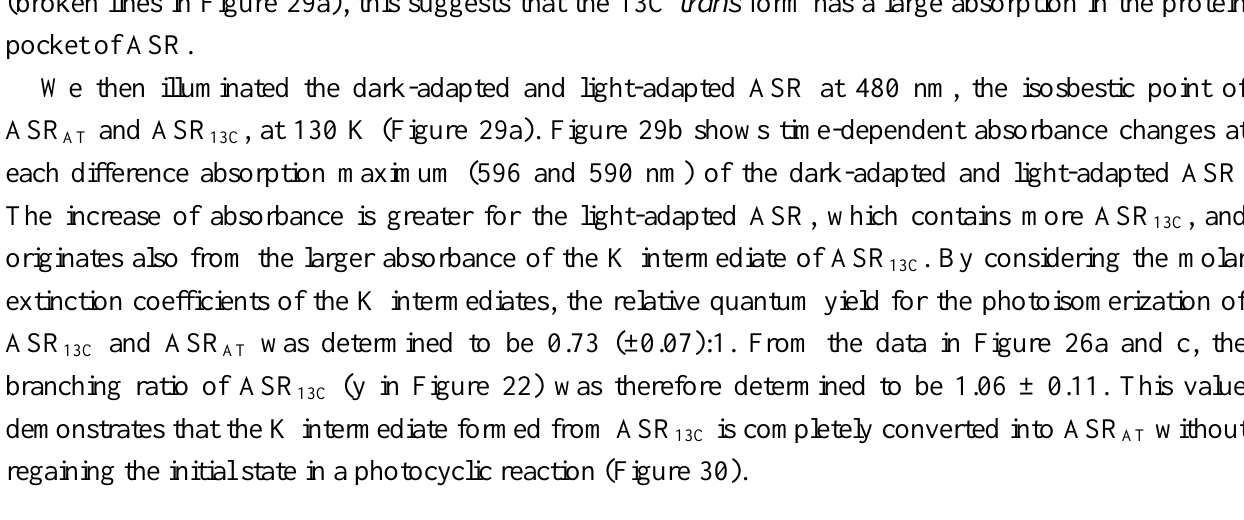
and ASR ) convert 100% AT 13C